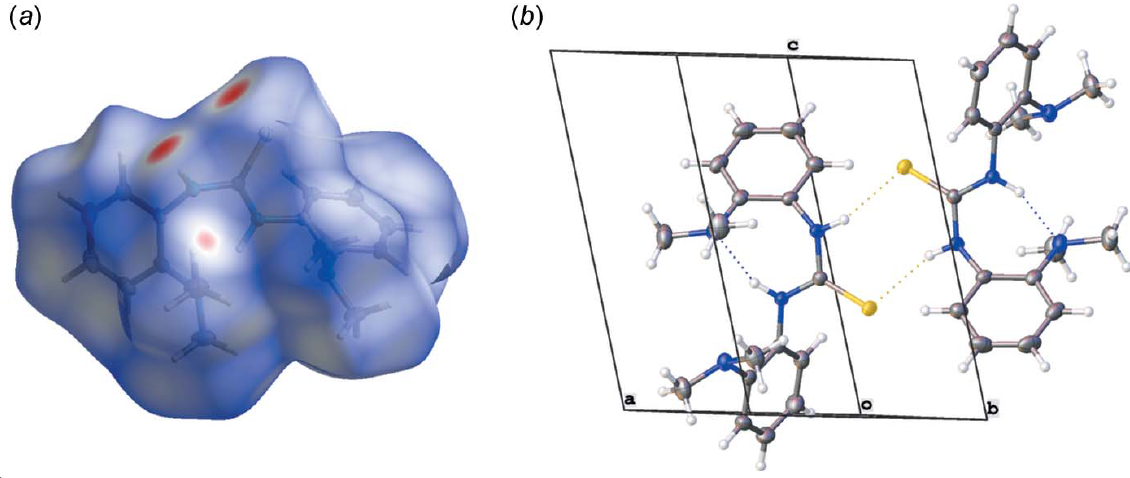
Figure 3 ( a ) Hirshfeld surface mapped over d norm in the range (cid:2) 0.27 to 1.29. ( b ) Partial packing plot of 1 .